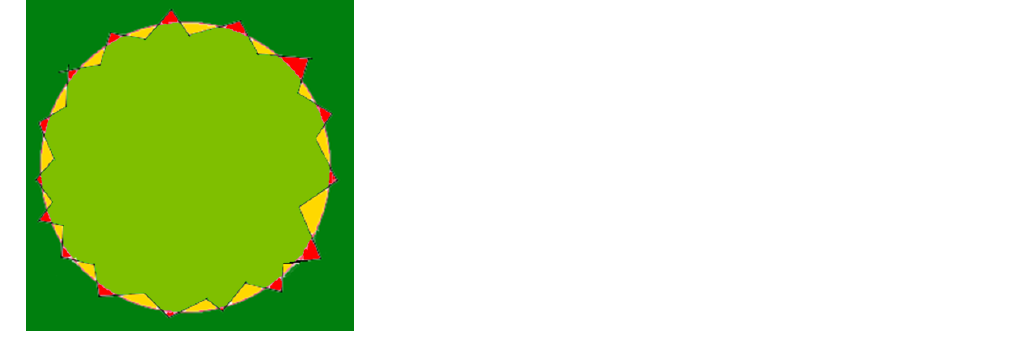
Figure 8. The cloud boundary approximation: TP (light green), TN (bottle green), FN (yellow) and FP